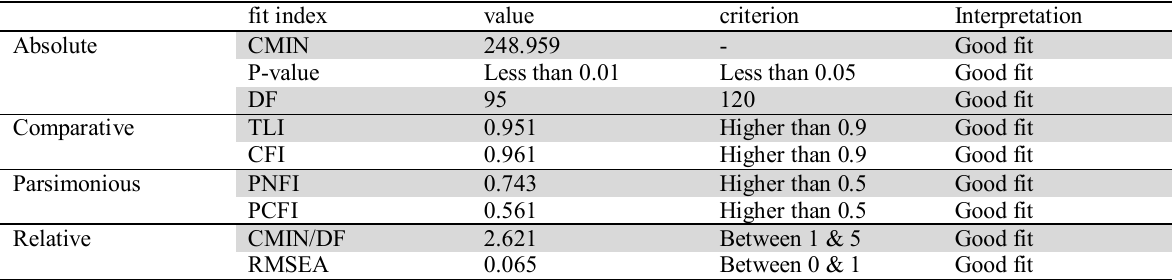
Goodness of fit Indices for the